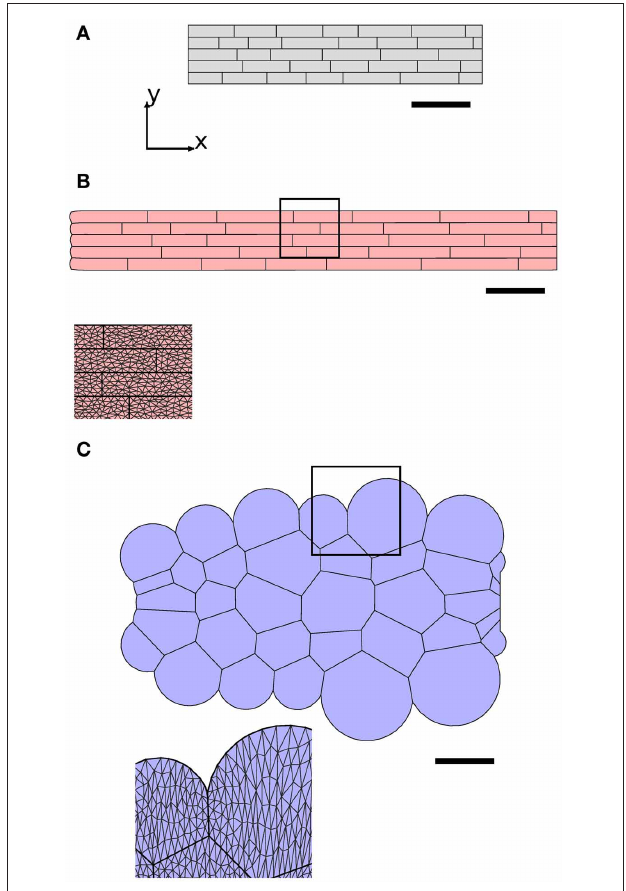
FIGURE 5 | Viscous cell walls in the plane of the simulation avoid transverse swelling of cells. The synthetic geometry (A) was used to initialize simulations, with results at t = 1hr shown in (B) and (C) . In (B) , with large anisotropic wall viscosity, cells retain their rectangular shape and elongate in the x -direction, whereas in (C) , with no anisotropic viscosity and only small isotropic wall viscosity ( μ 1 = 0 . 002MPahr, μ 2 = μ 3 = 0MPahr), cells become rounded. Scale bars indicate 100 μ m. Parameters are as listed in Table 1 , except that μ axial = 10 . 0MPa μ mhr in (C) to compensate for loss of cell-wall viscosity in the plane of simulation. 7772 triangular elements were used for the cell walls in the plane of the simulation; these elements are visible in the magnified